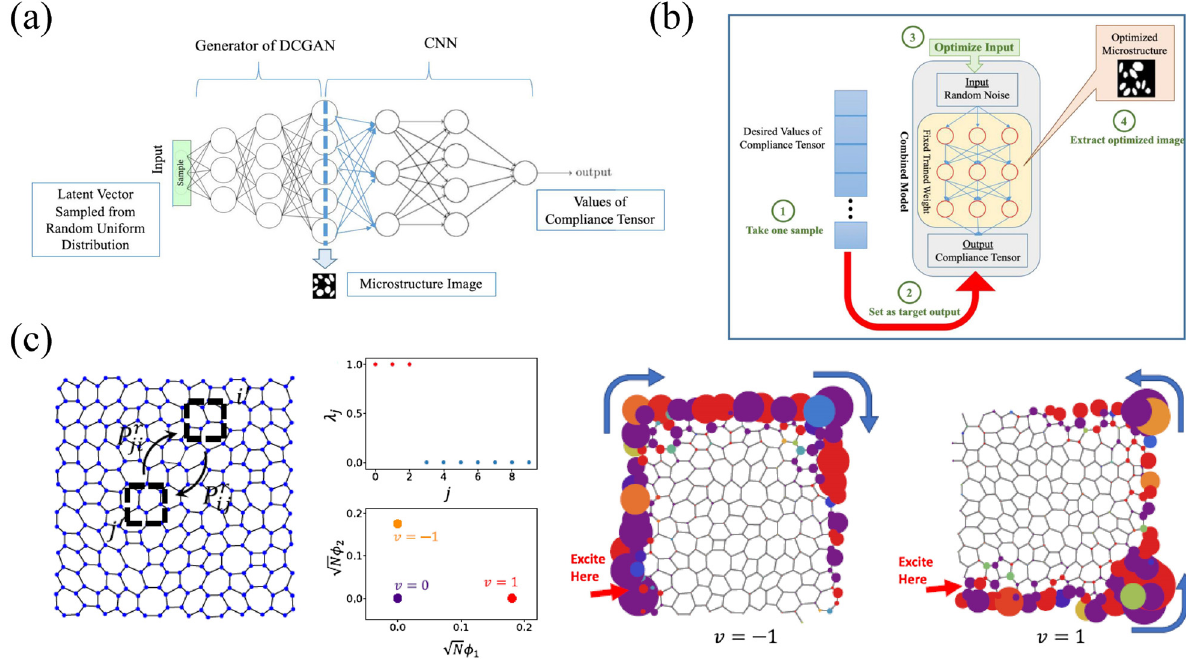
Figure 9: Application cases of generative model and unsupervised manifold clustering for elastic metamaterials. (a) and (b) is the process for the design of 2D porous microstructures [126]. (c) Classi fi cation of topological phononic crystals based on unsupervised manifold clustering